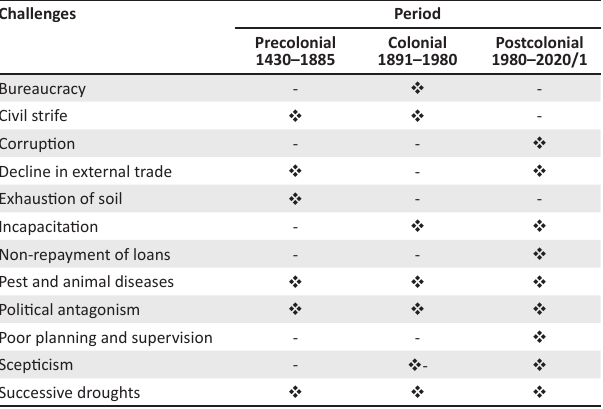
TABLE 2: A historical visual footprint of challenges for Zimbabwe’s food security initiatives.